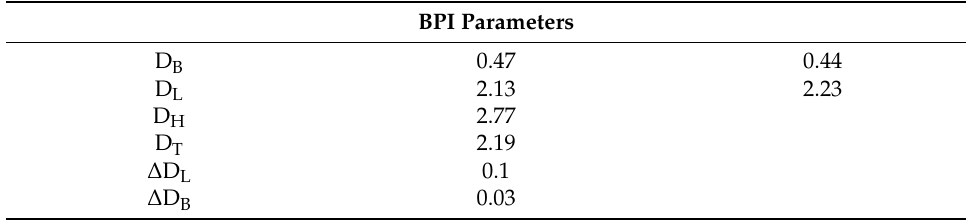
Table 7. Beam purity indicator optical film